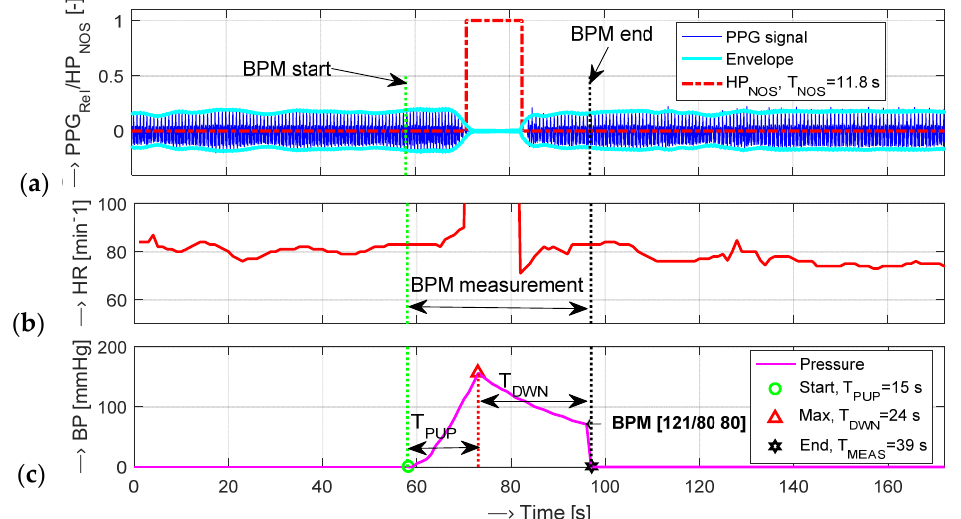
Figure 6. Visualization of a PPG wave sensed from the left little finger with parallel BP measurement on the same arm: ( a ) the PPG signal and its envelopes together with determined T NOS ≅ 10 s, ( b ) HR values determined from the PPG signal, ( c ) the pressure characteristic measured by the BPM device with determined T PUP , T PDWN , and T PMEAS time intervals, BP and HR values.